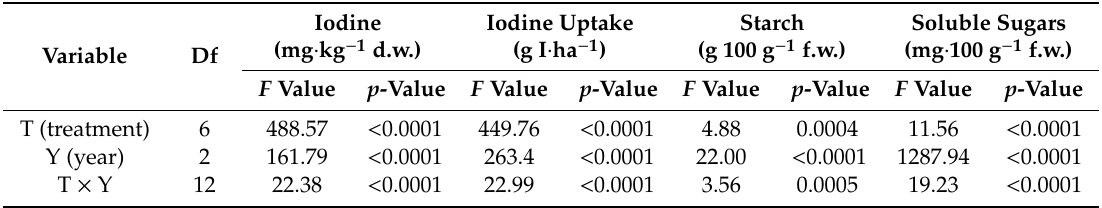
Table 6. Summary of analysis of variance of iodine content and uptake as well as the content of starch and soluble sugars in potato tubers.